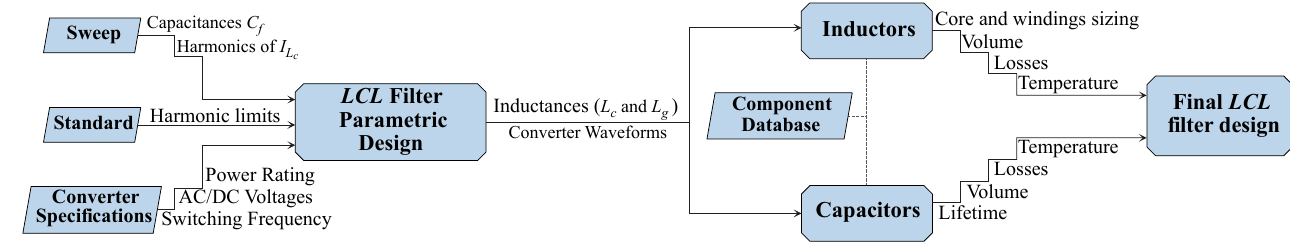
Figure 1. Diagram illustrating the developed